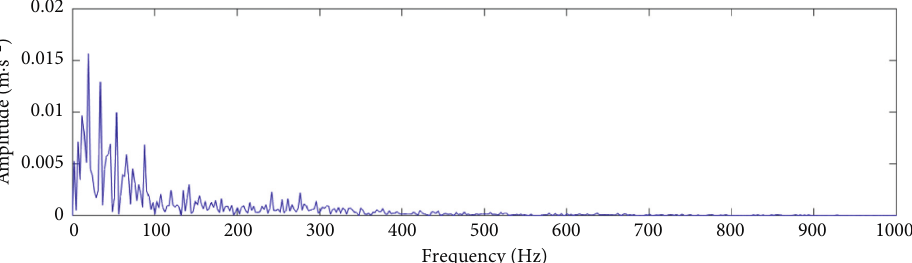
Figure 21: Envelope spectrum of IMF2.